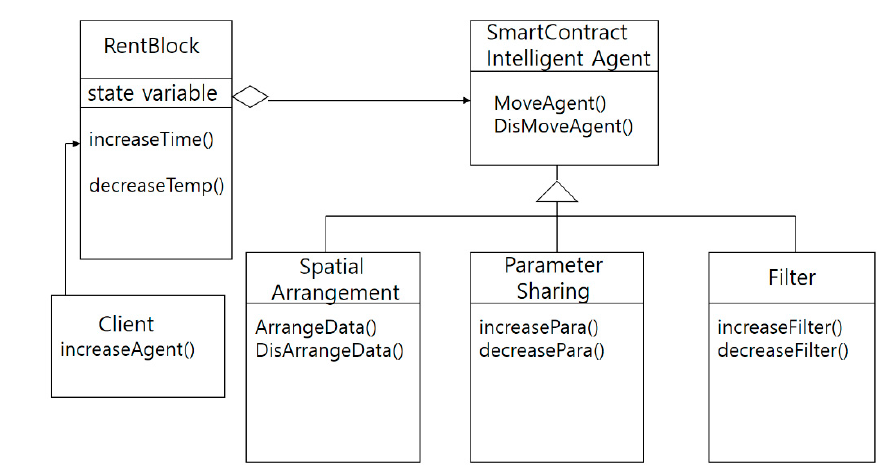
Figure 7. Unified modelling language (UML, class diagram) for real estate.